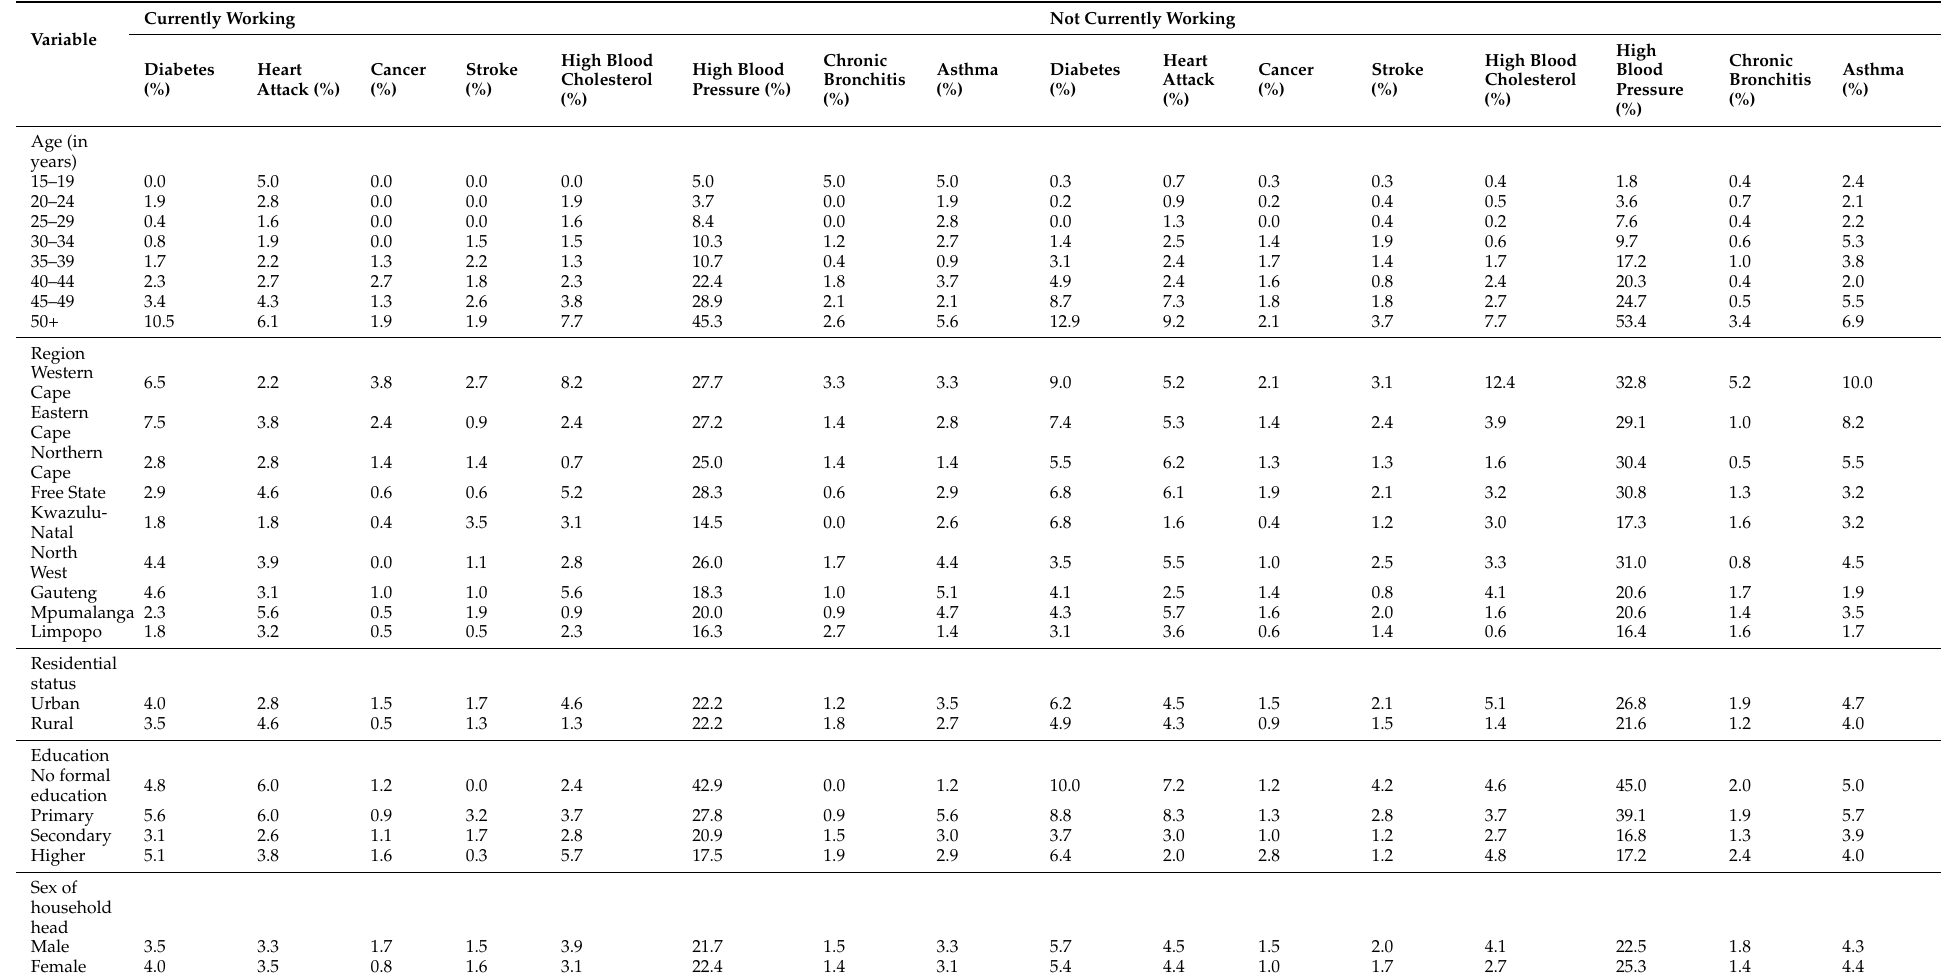
Table 2. Prevalence of diabetes and selected chronic diseases across women’s characteristics by labour force participation